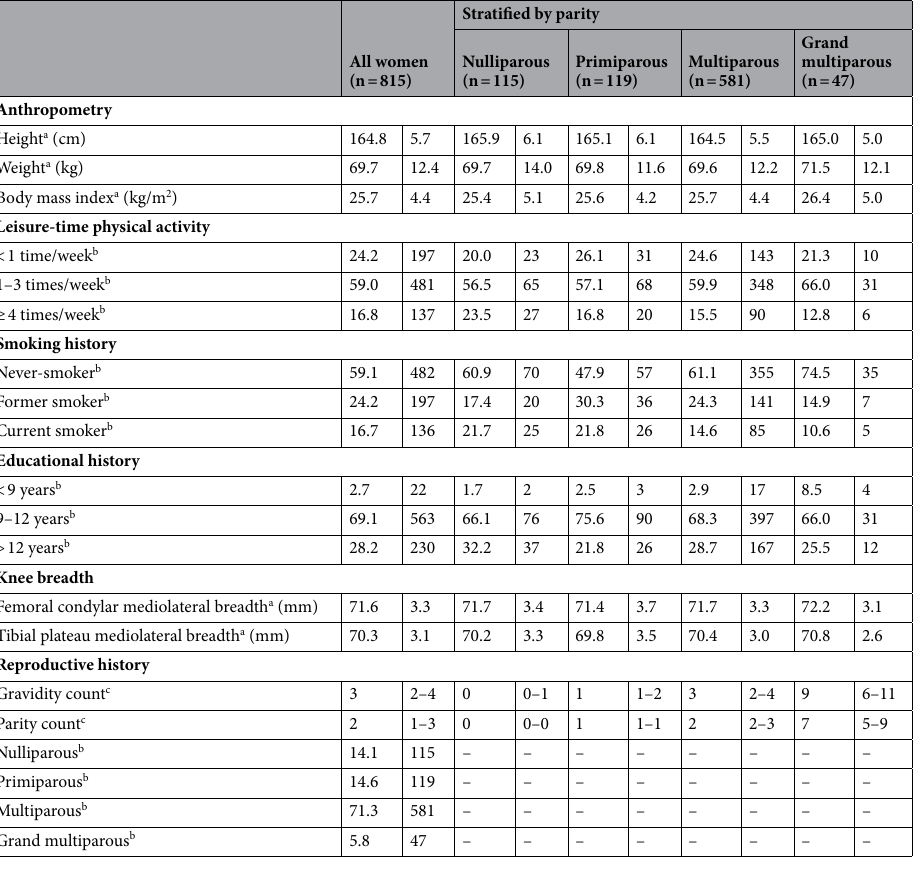
Table 1. Main characteristics of the study population. a Values are means with standard deviations. b Values are percentages with frequencies. c Values are medians with interquartile ranges.